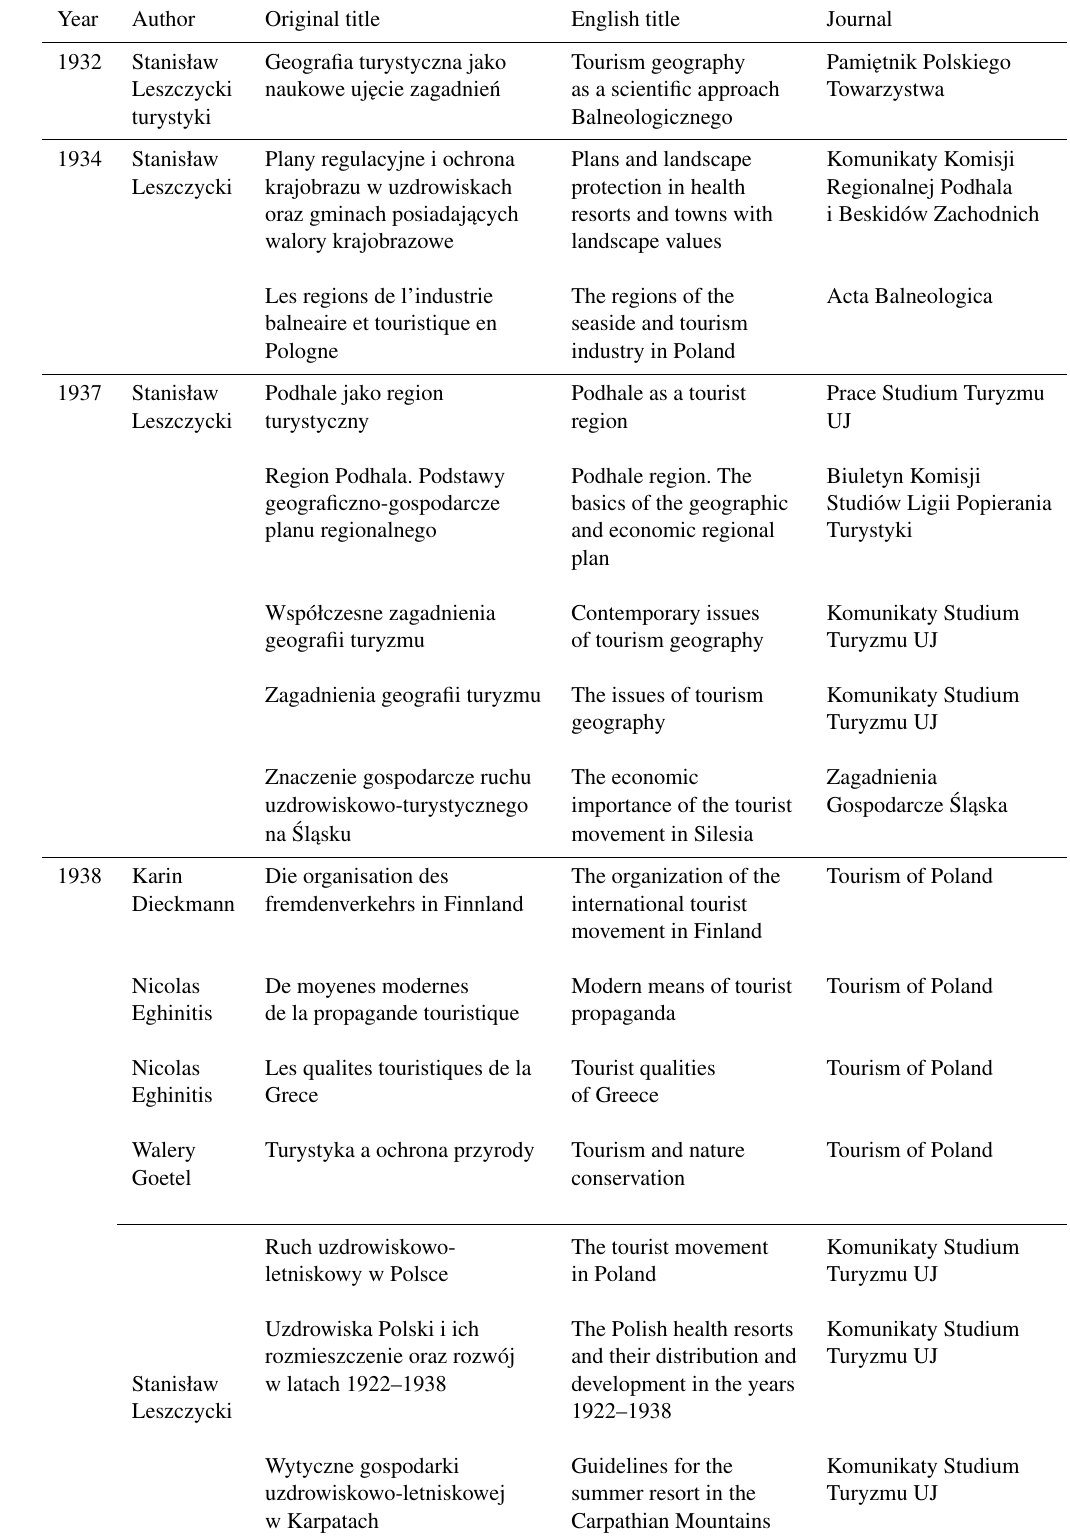
Table 3. The selected articles published by the Jagiellonian University School of Tourism (source: authors’ own work based on archival materials of the